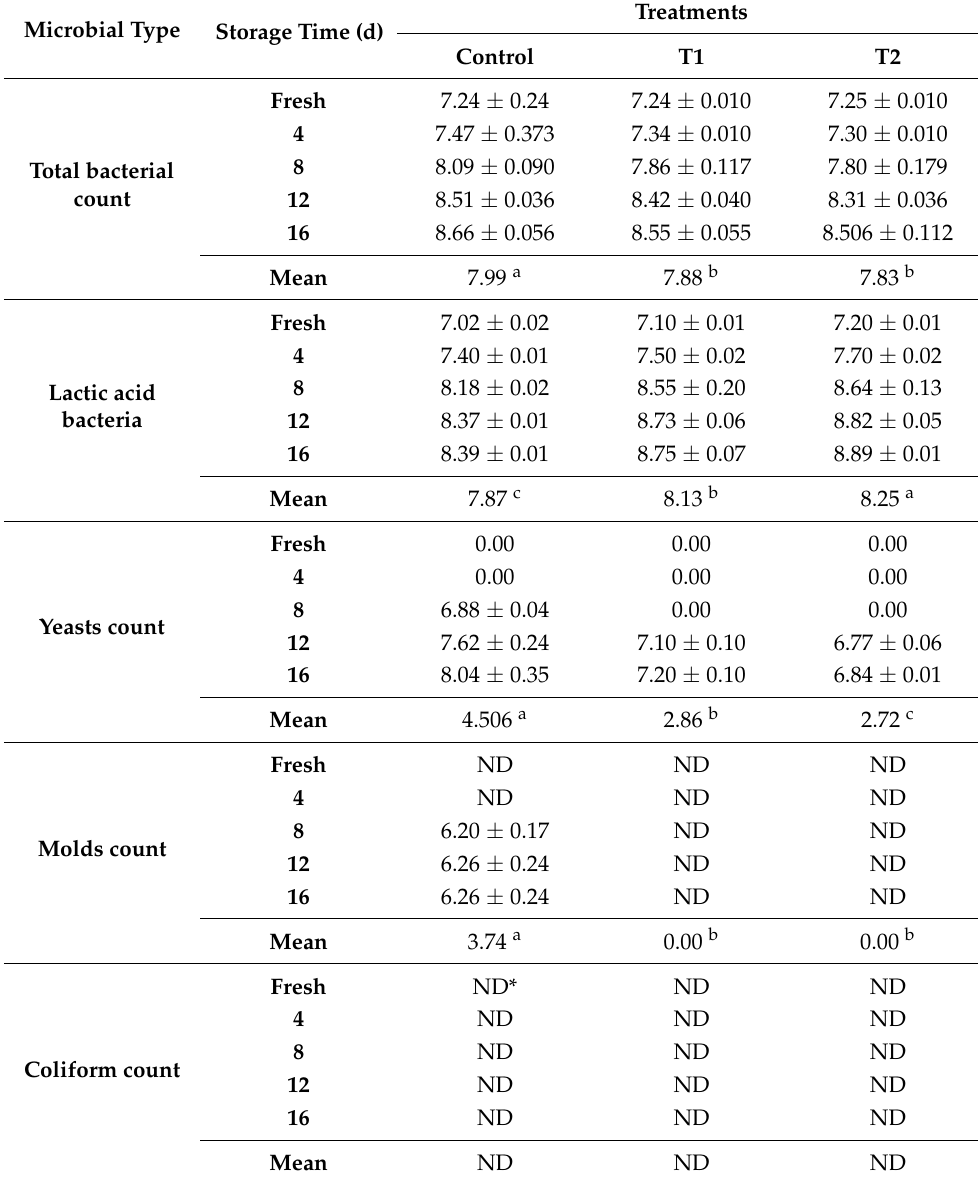
Table 4. Effect of REO on microbiological properties (Log cfu/mL) of SLY during storage periods (mean ± standard